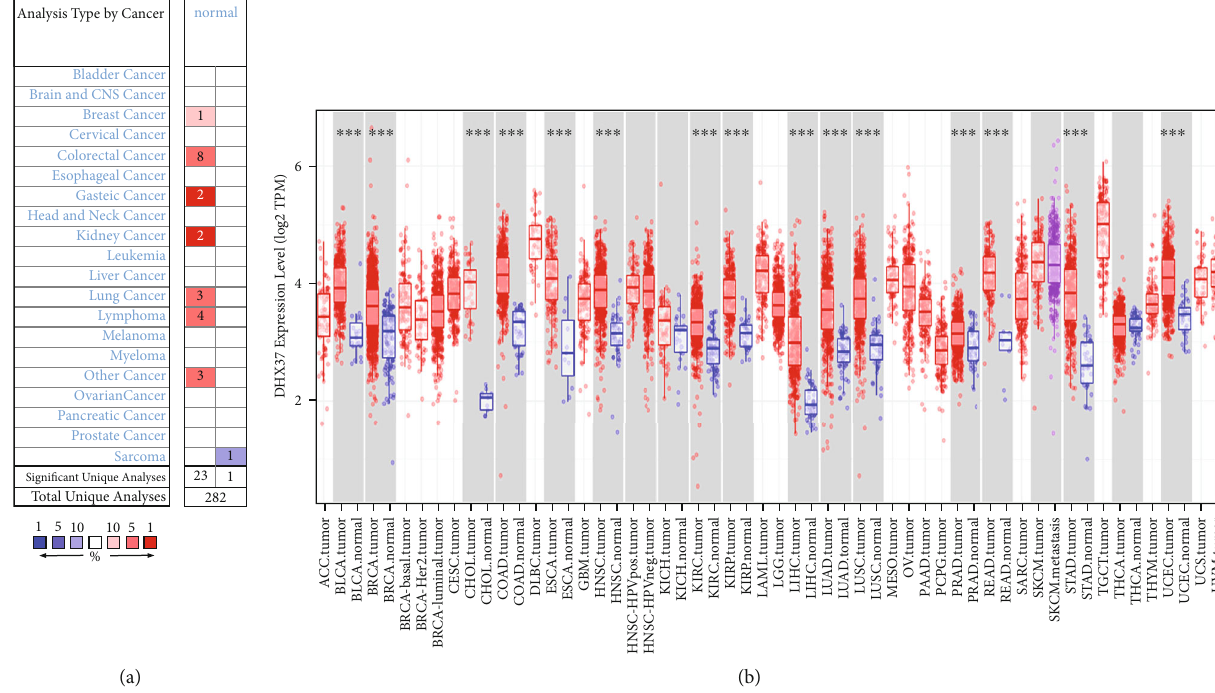
Figure 1: DHX37 expression levels in cancers. (a) Increased or decreased expression of DHX37 in di ff erent cancer tissues compared with normal tissues in the Oncomine database. Number in each cell is the number of datasets. Red indicates high expression and blue indicates low expression. (b) Human DHX37 expression levels in di ff erent cancer types from TCGA data in TIMER. ∗ P < 0 : 05 , ∗∗ P < 0 : 01 , ∗∗∗ P < 0 : 001 . Red indicates tumor and blue indicates normal